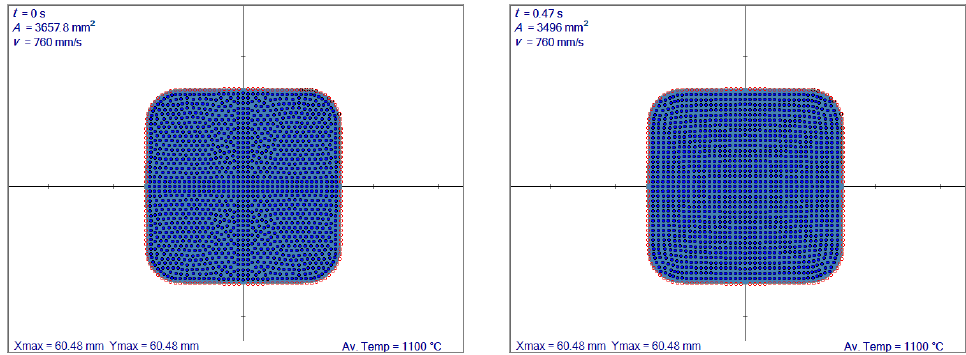
Figure 8. Irregular nodes (on the left ) and regular nodes with mapping (on the right ). Av. Temp. stands for average temperature.